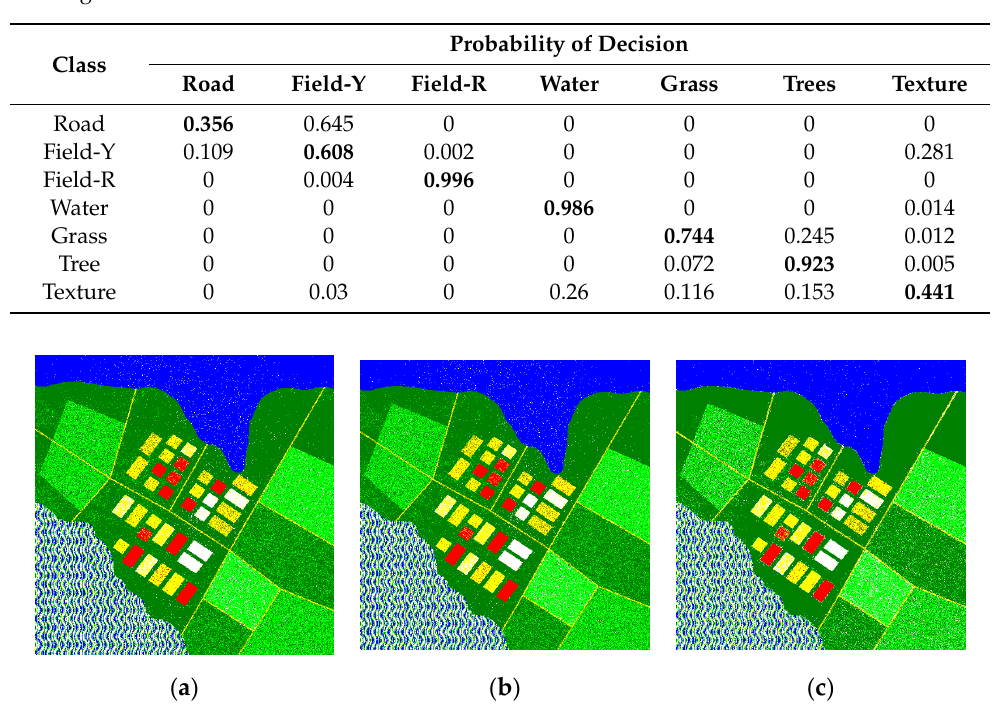
Figure 5. Classification results: for compressed image (PSNR-HVS-M = 42 dB) ( a ), for compressed image (PSNR-HVS-M = 36 dB) ( b ); for compressed (PSNR-HVS-M = 30 dB) ( c ).